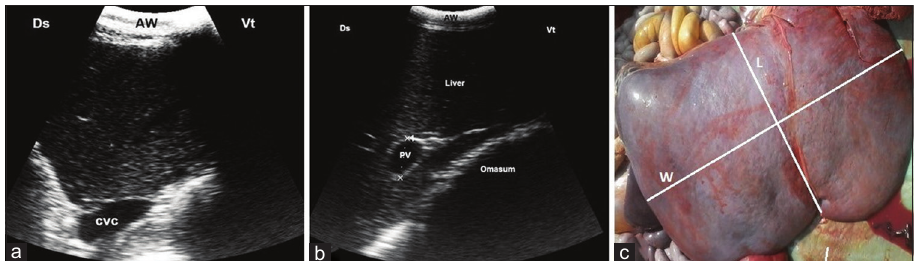
Figure-1: (a) Ultrasonography (US) of the normal liver of buffaloes at the level of the right 11 th ICS shows a triangular appearance of caudal vena cava. (b) US of normal portal vein appears with echogenic wall at the level of the 9 th ICS. (c) Necropsy of normal liver showing normal brownish color with 25 cm length (L) and 50 cm width (W). AW=Abdominal wall, Ds=Dorsal, Vt=Ventral.